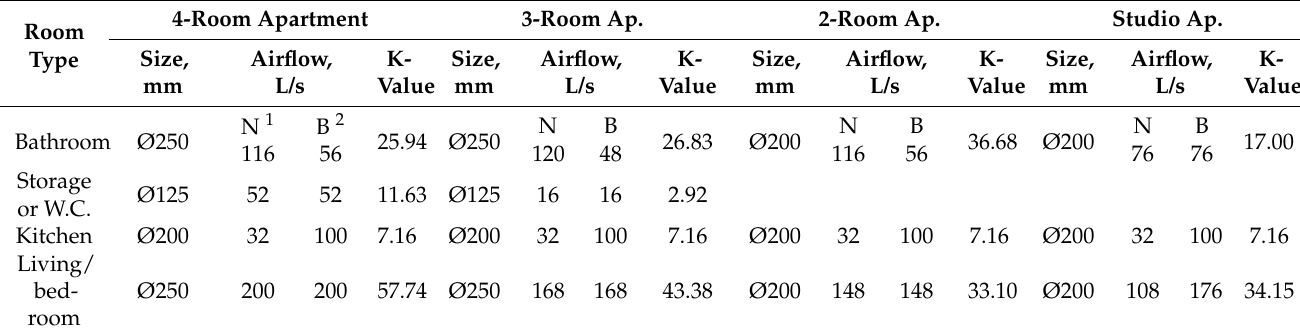
Table 2. Airflow rates of the branch-level balancing damper, k values and ductwork sizes.